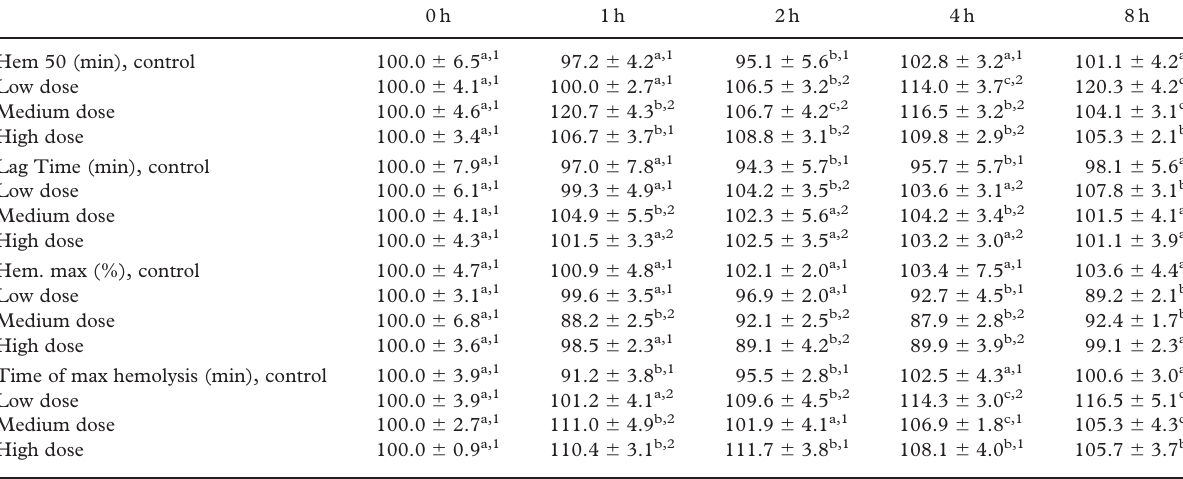
Table I. Parameters measured from the hemolysis curves of erythrocytes.